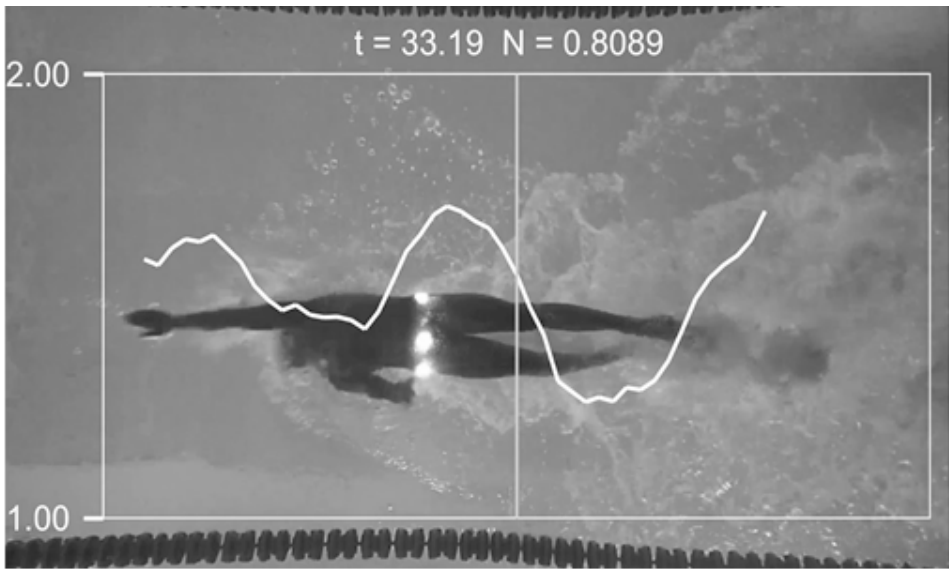
Fig. 1. An example of a shot of an underwater video recording with an overlaid graph of intra cycle speed. The ordinate axis is time, the abscissa is instantaneous speed (m/s). The vertical line in the center of the graph indicates the point on the graph that corresponds to this